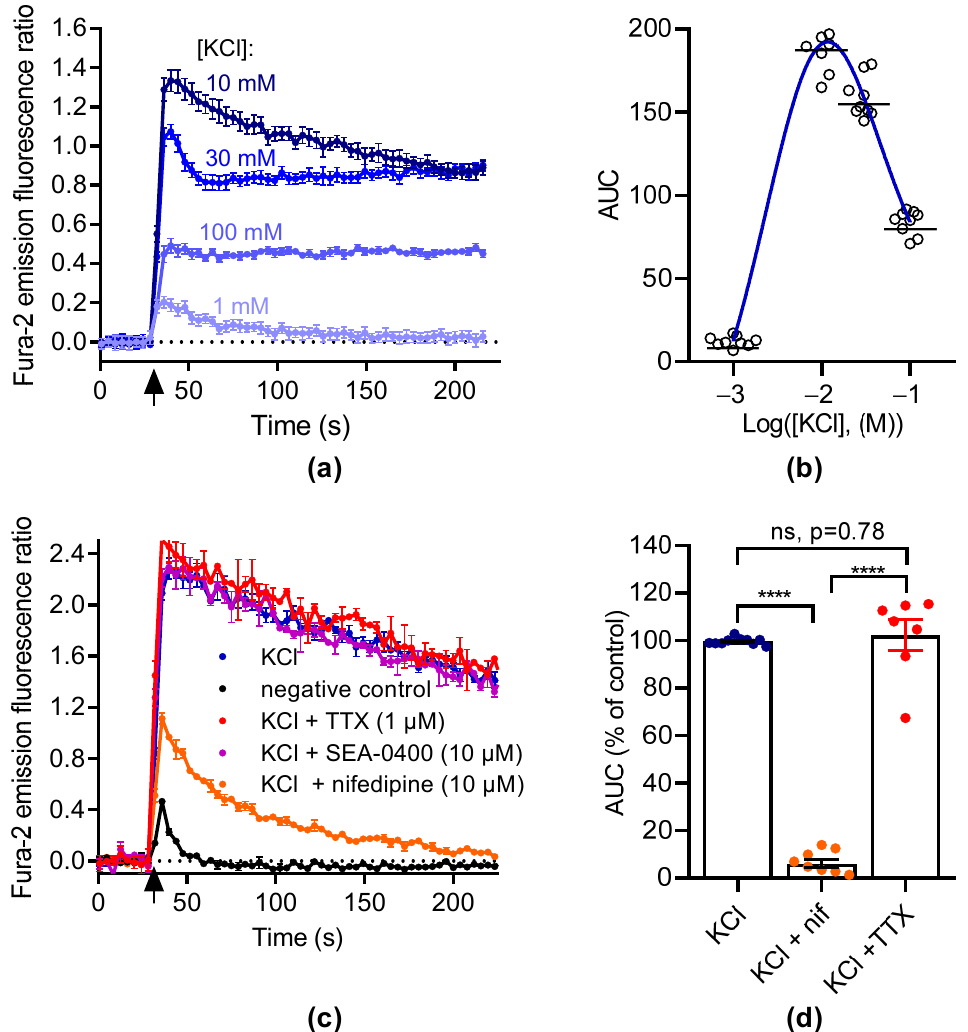
Figure 2. KCl induces intracellular Ca 2+ increase in GH3b6 cells. ( a ) Representative kinetic traces of KCl-induced Ca 2+ responses. The fluorescence emission ratio of Fura-2 increased after the injection of KCl (black arrow) at 1, 10, 30, and 100 mM, respectively. ( b ) The concentration–Ca 2+ response relationship for KCl is described by a bell-shaped curve. The AUC of kinetic traces of KCl-induced Ca 2+ responses were fitted by a bell-shaped curve equation. The horizontal dashes represent the mean value. ( c ) Representative kinetic traces of Ca 2+ responses induced by KCl at 10 mM in the absence and presence of nifedipine (10 µM), TTX (1 µM), and SEA-0400 (10 µM), respectively. As a negative control, HBSS was injected alone. ( d ) The scatter plot illustrates the effects of nifedipine (10 µM) and TTX (1 µM) on Ca 2+ responses induced by 10 mM KCl. The AUC of fluorescence emission traces over time were normalized using maximum response to 10 mM KCl. The bars represent the mean ± SEM. Significance between groups was analyzed by one-way ANOVA ( p < 0.0001) followed by Tukey’s post hoc multiple comparison test. ****, p < 0.0001; ns, nonsignificant. Data are shown as mean ± SEM ( a , c : n = 3; b : n = 9).